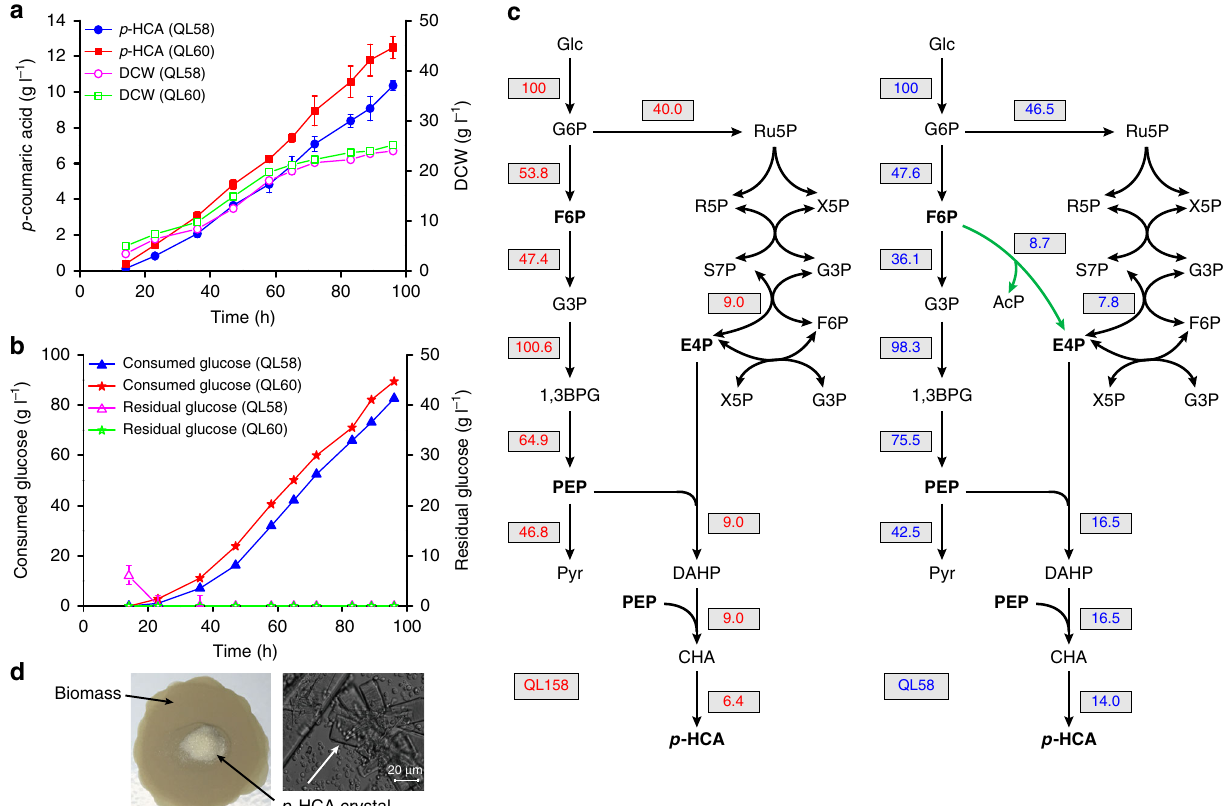
Fig. 6 High-level production of p -HCA. a Fed-batch fermentation of strain QL58 and the corresponding diploid strain QL60 under glucose-limited conditions over time. p -HCA titer ( fi lled symbols) and cell mass (open symbols) are shown for each strain. b Glucose consumption pro fi le ( fi lled symbols) and time course of residual glucose (open symbols) during the same fed-batch fermentation for each strain. All data represent the mean of n = 2 biologically independent samples and error bars show standard deviation. c Predicated metabolic fl ux distributions via fl ux balance analysis (FBA) in the engineered medium-level p -HCA producer QL158 (left, without carbon-rewiring strategy) and high-level p -HCA producer QL58 (right, with carbon- rewiring strategy). Based on FBA, the fl uxes to the different products were represented relative to the uptake of 100 mmol of glucose. The PHK pathway, the nonnative E4P-forming biosynthetic pathway, is highlighted in green. 1,3BPG 1,3-biphosphoglycerate; see Fig. 1 legend regarding abbreviations of other metabolites. d Observed p -HCA crystals on fi lter membrane (left panel) and under a microscope (right panel, scale bar = 20 µ m). Crystals of p -HCA were formed as a result of its high-level production and relatively low solubility in the fed-batch fermentation broth. The source data underlying fi gure a and b